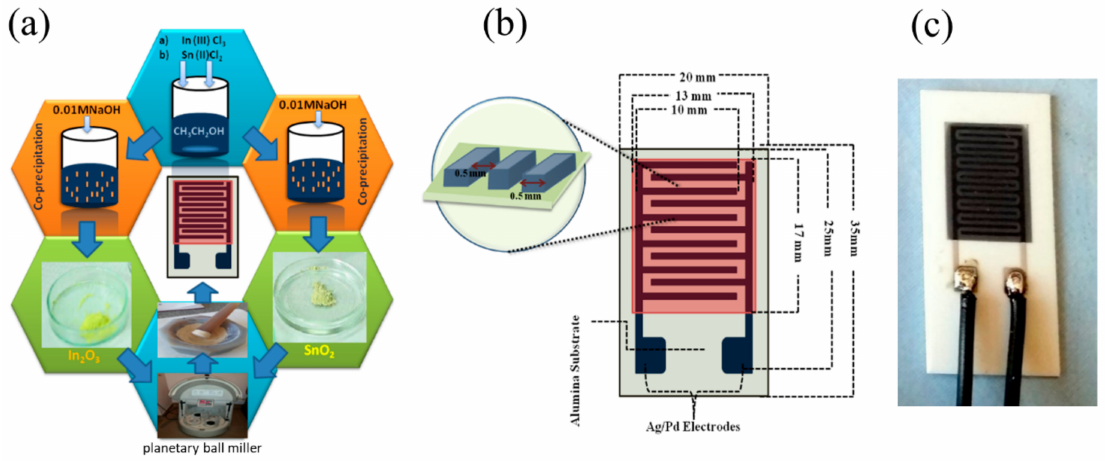
Figure 1. ( a ) Steps involved in synthesis process, ( b ) schematic representation of SnO 2 -In 2 O 3 nanocomposite-based interdigitated capacitive (IDC) sensor structure, ( c ) fabricated sensor on alumina